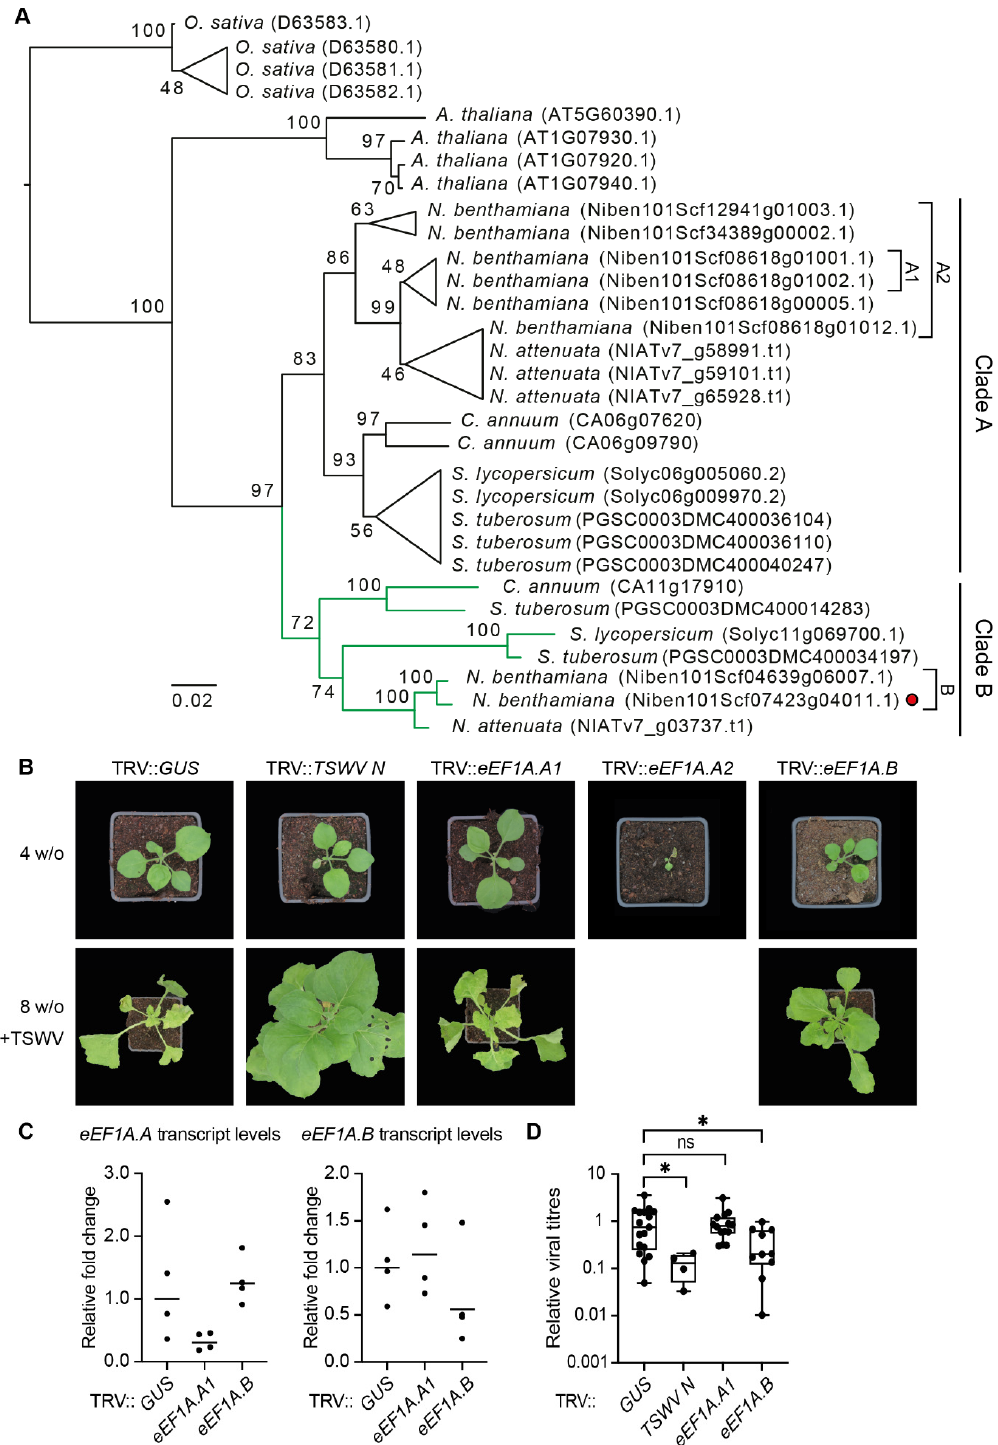
Figure 4. Solanaceous eEF1A isoforms cluster in two clades, clade A and B, of which clade B is required for TSWV susceptibility. ( A ) Phylogenetic analysis of the eEF1A coding sequences retrieved from Arabidopsis , Capsicum annuum, Nicotiana attenuata, N. benthamiana , Oryza sativa, Solanum lycopersicum , and S. tuberosum . The red dot indicates the eEF1A homologue of N. benthamiana that co-purified with viral RNPs. A1, A2, and B denote the VIGS constructs targeting the different N. benthamiana eEF1A genes. ( B ) Growth phenotype of N. benthamiana upon VIGS of eEF1A.A1 , eEF1A.A2 , or eEF1A.B , using TRV two weeks post agro-inoculation of the VIGS construct. ( C ). eEF1 A transcript levels of the plants shown in ( B ) (n = 4). Unpaired Student’s t-test (*, p -value < 0.01). ( D ) DAS-ELISA showing the TSWV viral titres of plants shown in ( B ), at two weeks post TSWV